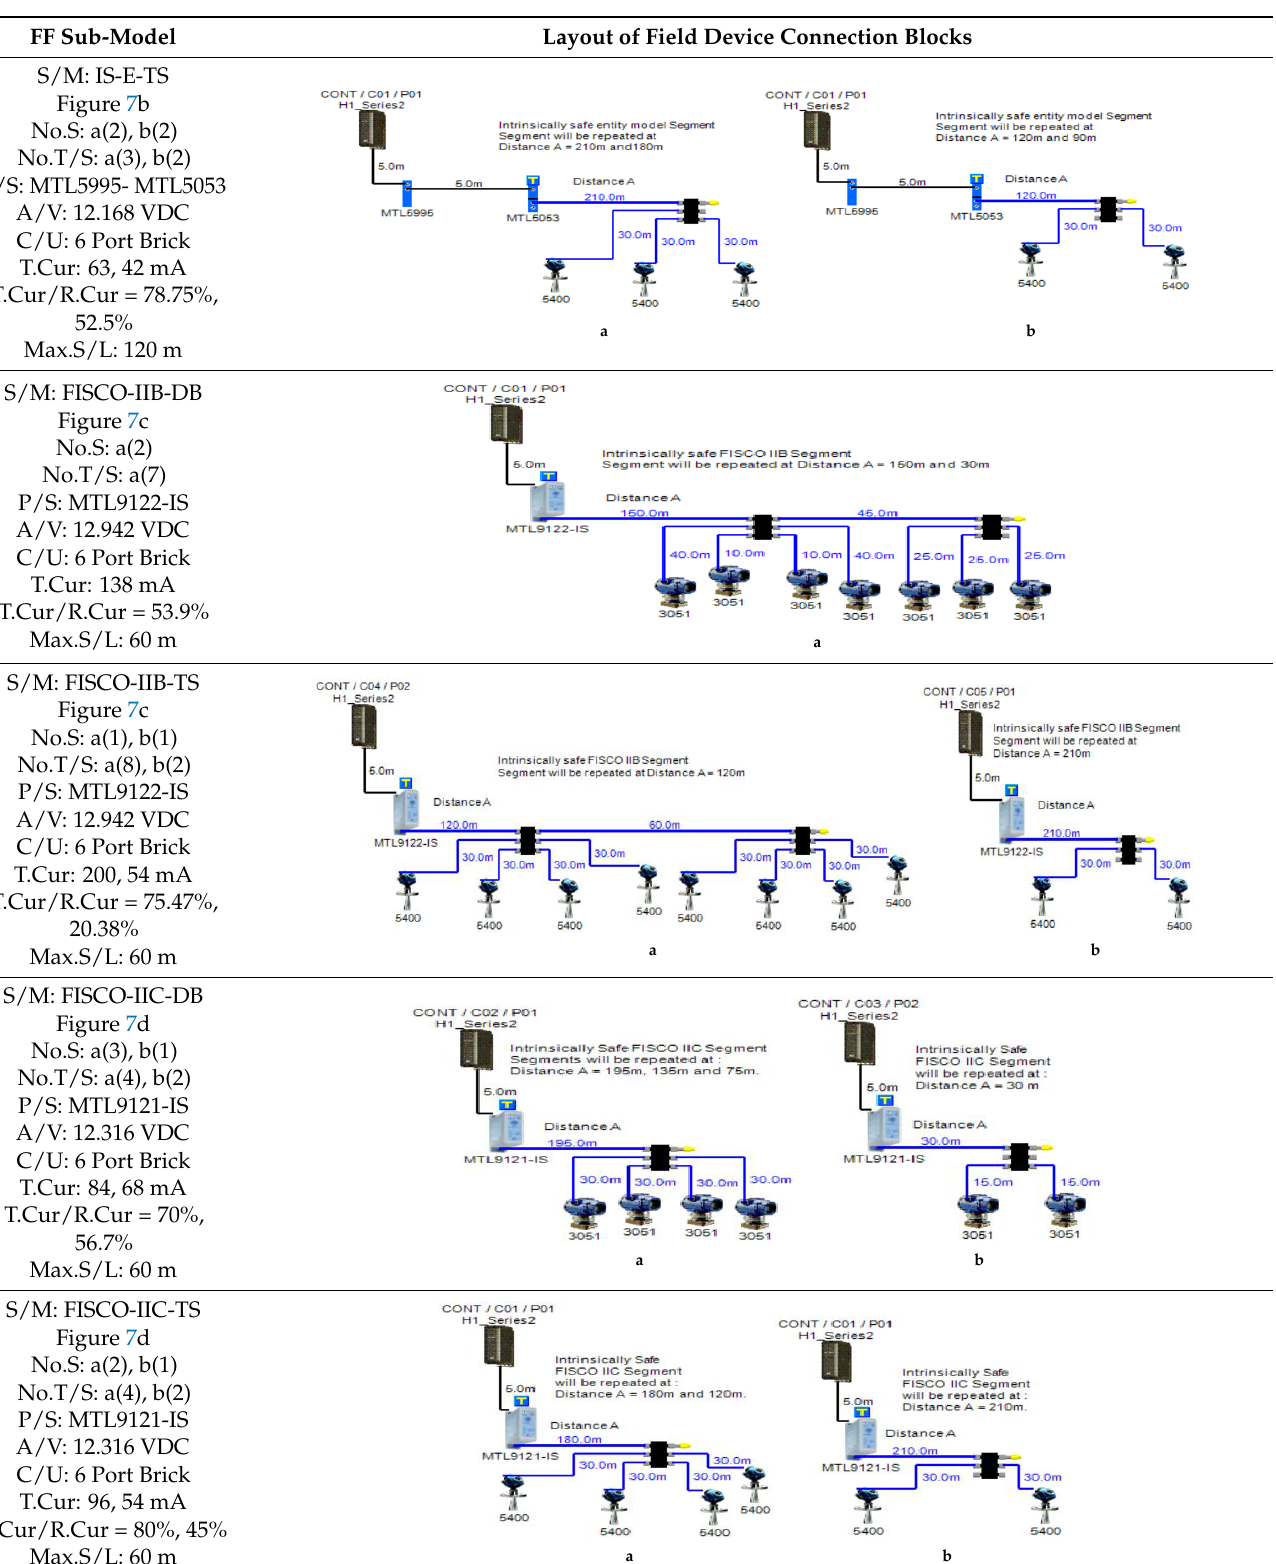
Layout of Field Device Connection Blocks